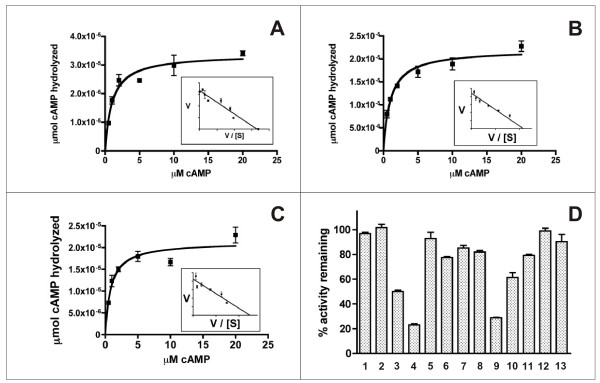
Characterization of PDE activity and inhibitor potency. Panel A: Michaelis-Menten kinetics of recombinant LmjPDEB2 with 3H-cAMP as substrate. Panel B: reaction in the presence of a 100-fold excess of unlabelled cGMP. Panel C: reaction in the presence of a 50-fold excess of unlabelled AMP. Inserts in A – C: corresponding Eadie-Hofstee plots. Panel D: Effect of PDE inhibitors on LmjPDEB2 activity (1 μM 3H-cAMP substrate, 100 μM inhibitor). 1, cilostamide; 2, zaprinast; 3, etazolate; 4, dipyridamole; 5, Ro-20-1724; 6, rolipram; 7, IBMX; 8, 8-methoxy-methyl-IBMX; 9, trequinsin; 10, papaverine; 11, milrinone; 12, pentoxifylline; 13, erythro-9-(2-hydroxy-3-nonyl)adenine (EHNA). Very similar results were obtained with LmjPDEB1.